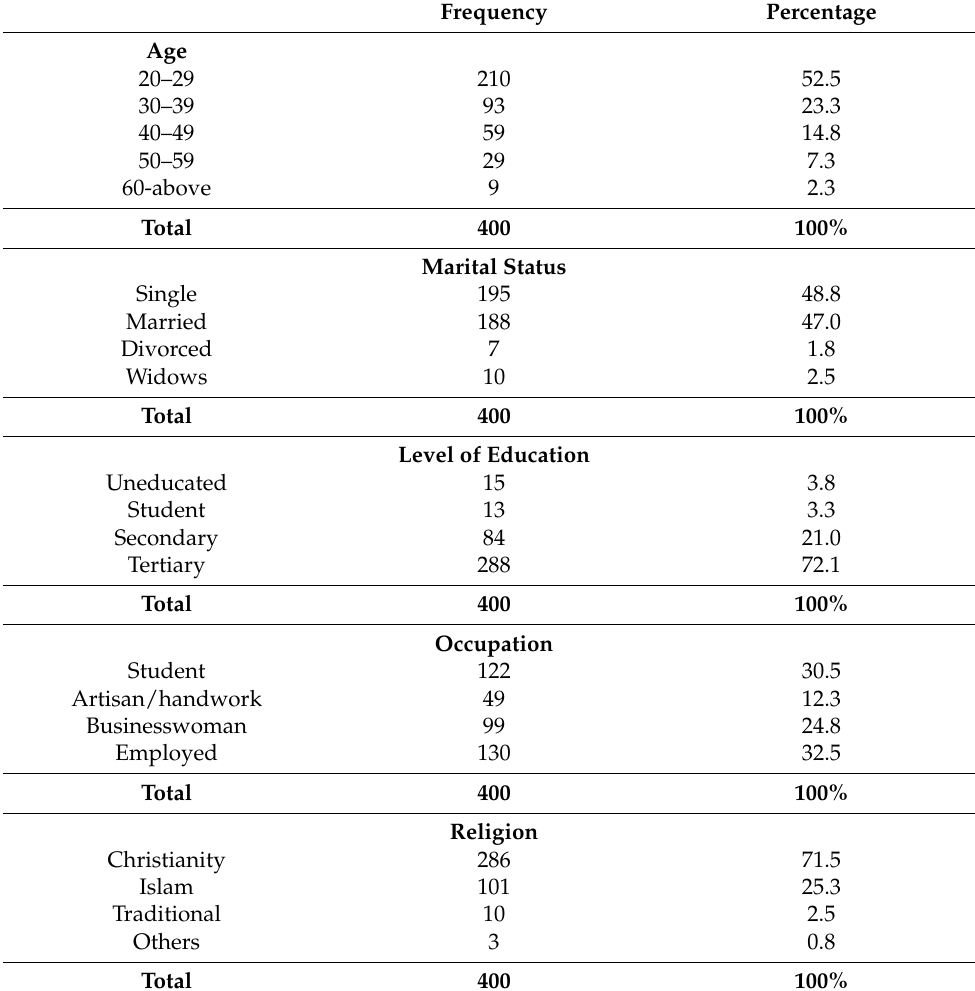
Table 1. Demographic Characteristics.